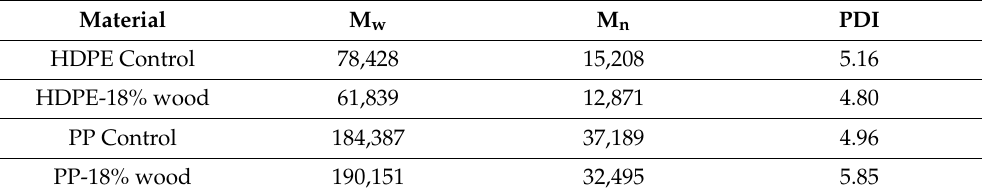
Figure 1. Overlay of FTIR spectra for the ( a ) HDPE wood composite and ( b ) PP wood composite samples with different percentage weight of filler. Table 1. Changes in the average molecular weights (g/mol) of the HDPE and PP composites with 18% wood